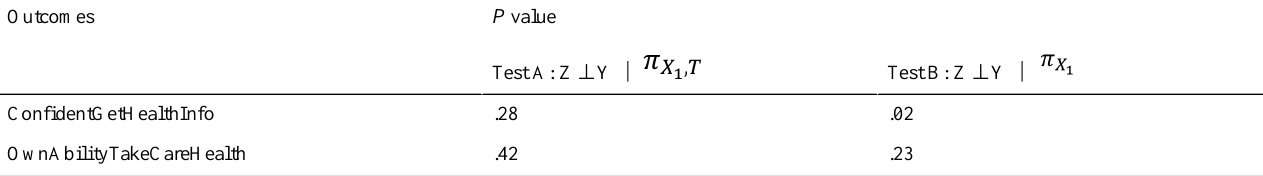
Table 2. Results of conditional independence tests.